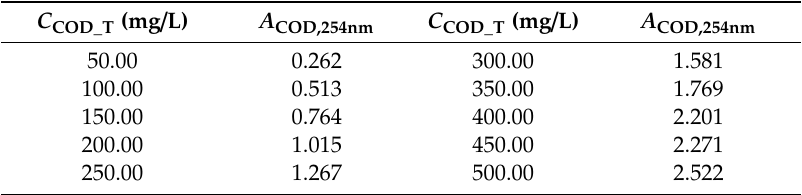
Table 3. Absorbance of di ff erent concentrations of COD standard solution at 254 nm.